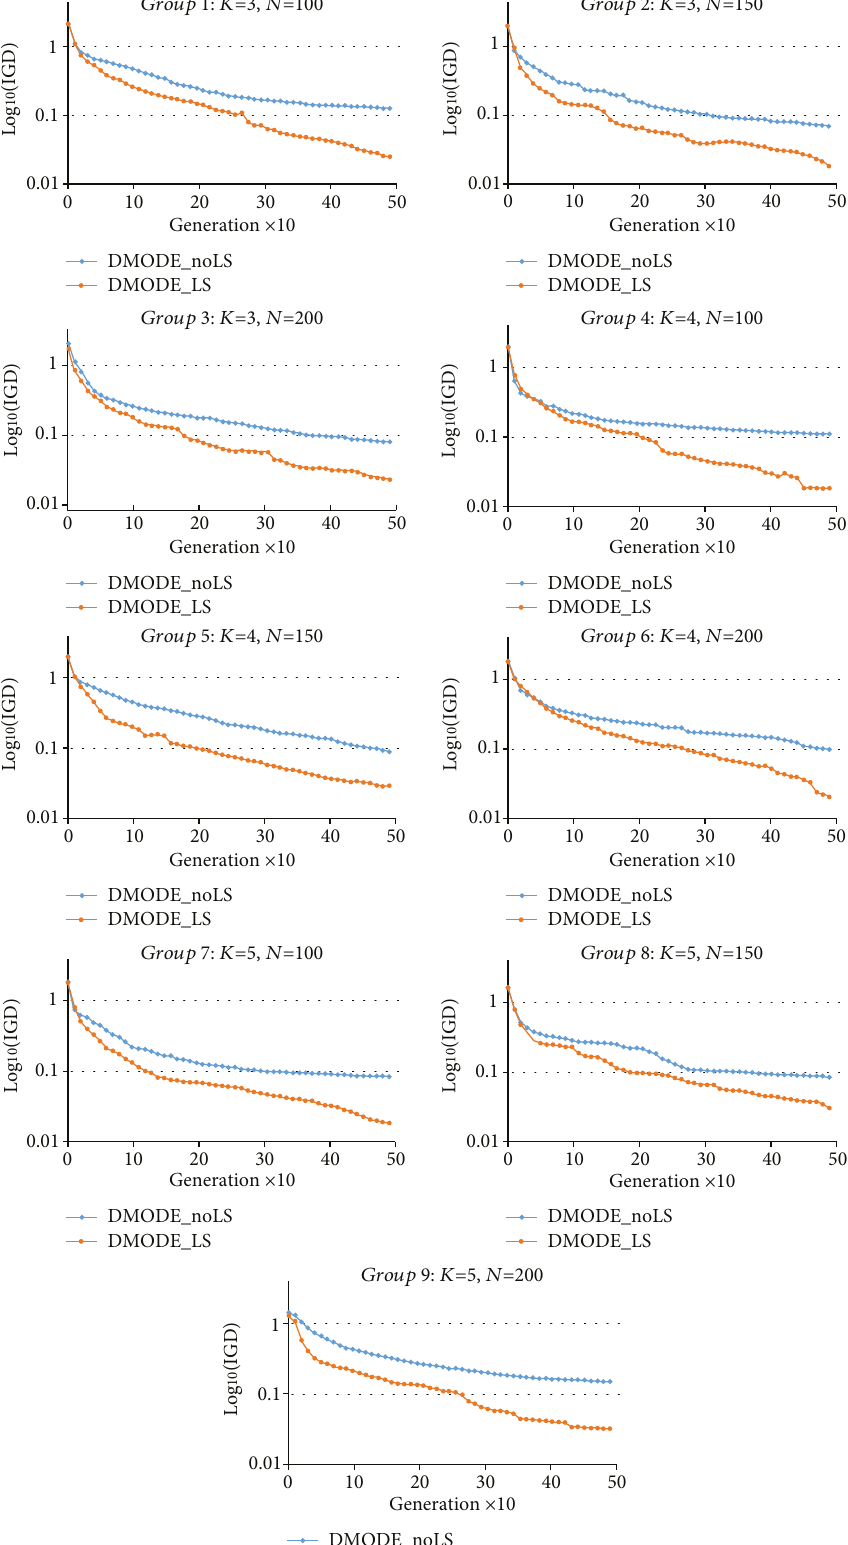
Figure 10: Evolution process of the IGD metric for the two algorithms with and without local